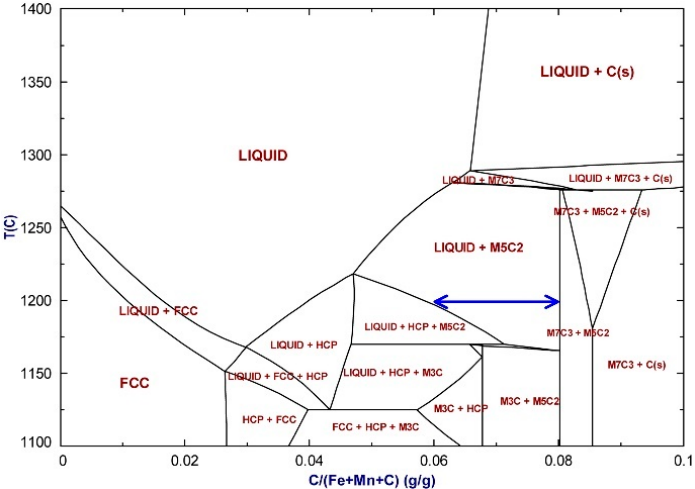
Figure 11. Mn activity vs. %Mn in Sample B (1200 °C, 5% Fe).